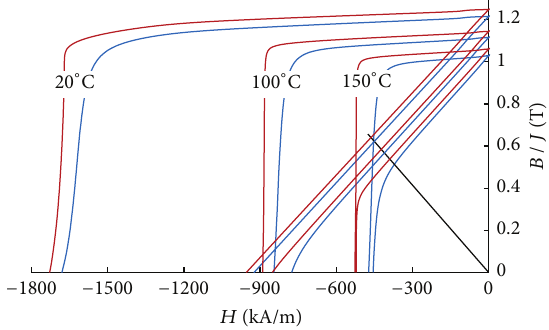
Figure 1: The BH and JH curves measured for the studied materials at 20 ∘ C, 100 ∘ C, and 150 ∘ C. The red line refers to material 1 and the blue line to material 2. A load line representing the geometry of the samples ( 𝑃 𝑐 = 1.2 ) is also shown.